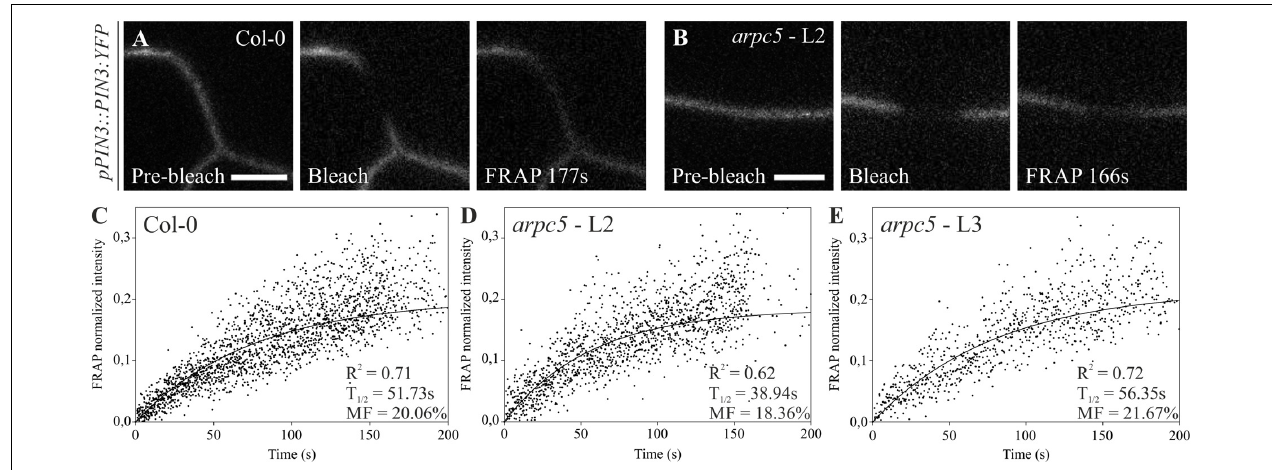
FIGURE 6 | Fluorescence recovery after photobleaching (FRAP) of pPIN3::PIN3:YFP auxin carrier in Col-0 (A,C) and arpc5 lines L2 (B,D) and L3 (E) . Photobleaching followed by its recovery was analyzed in transversal PM (plasma membrane) of three-day-old cotyledons expressing PIN3-YFP. Simple exponential fit was applied to normalized FRAP data; individual fluorescence intensities for multiple plants ( n = 6–14) are shown (scale bar = 5 µ m). The analysis was performed in three biological